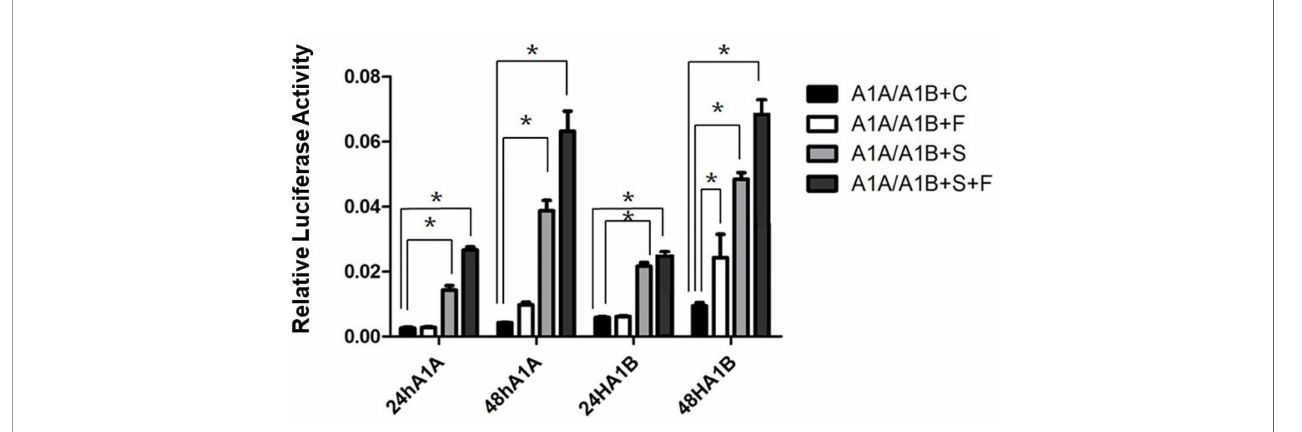
FIGURE 4 | Transcriptional activities of cyp19a1a and cyp19a1b promoters in HEK293T after 24h and 48h transfection. S meaned that only transcription factor SF-1 was added, F meaned that only transcription factor FOXL2 was added. S+F meaned that transcription factors SF-1 and FOXL2 were added at the same time. One-way ANOVA was performed on the data and expressed as mean ± standard deviation (n = 4). *There is a signi fi cant difference between the